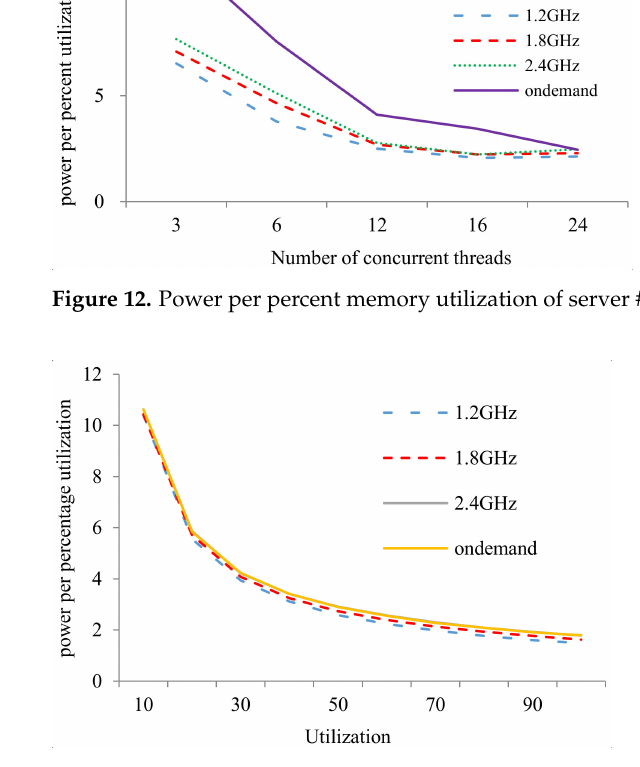
Figure 13. Power per percent utilization of server #2 running SPECpower benchmark.